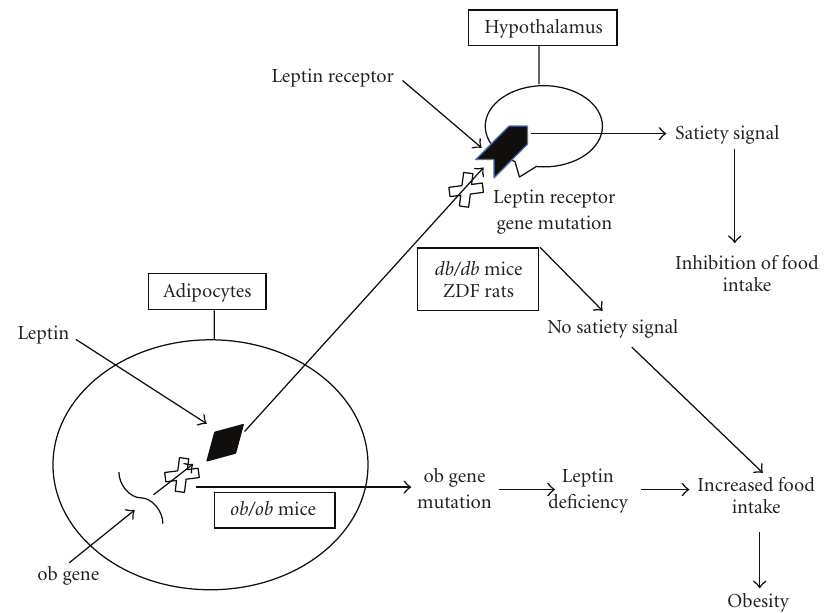
Figure 2: Mechanism of the actions of leptin including the e ff ects of leptin deficiency or leptin receptor